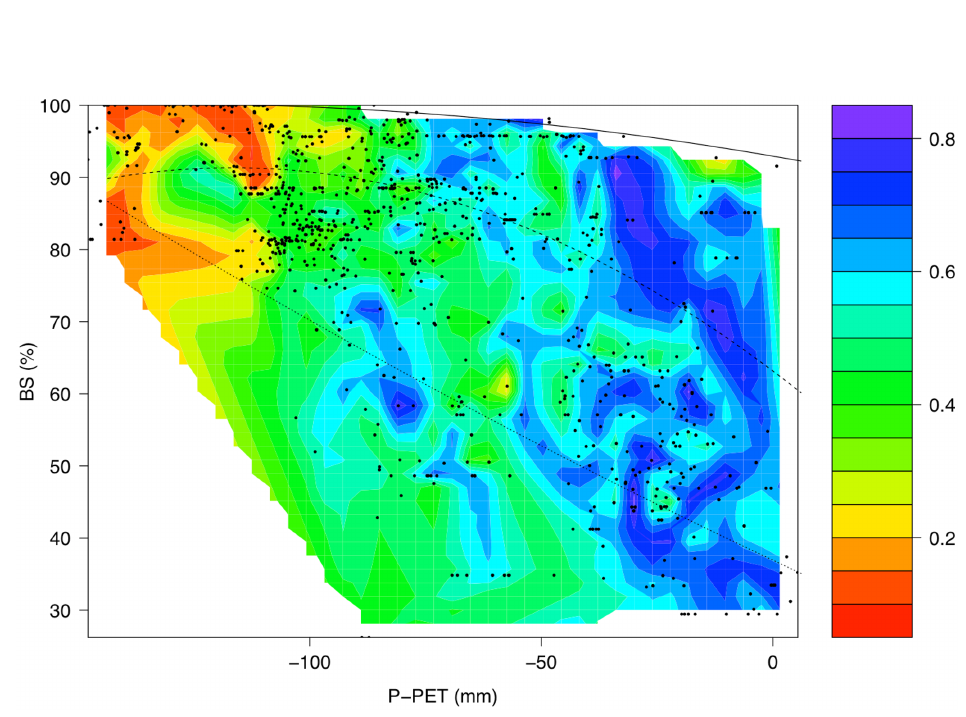
Fig 8. Contour plot of the average annual NDVI versus water availability (P-PET) and base saturation (BS) with a superimposed scatterplot for the entire dataset. The colours of the contour surface correspond to the NDVI values of the points (key on right). The solid, dashed and dotted lines represent the 95%, 50% and 5% quadratic quantiles, respectively, estimated using the ‘ quantreg ’ package [60] in R [57].